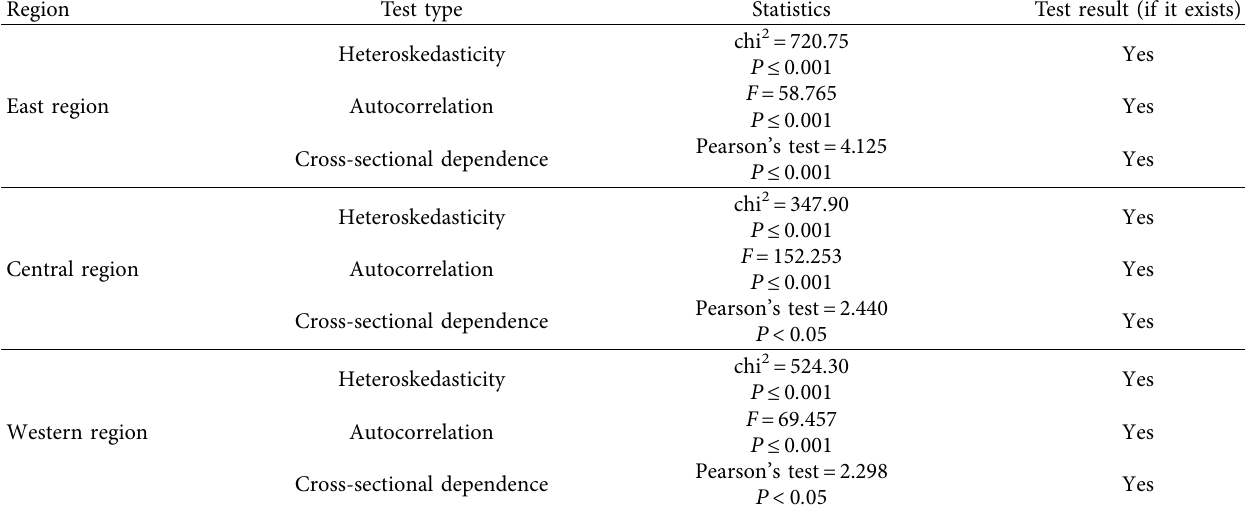
Table 7: Parameter estimation test of regional range